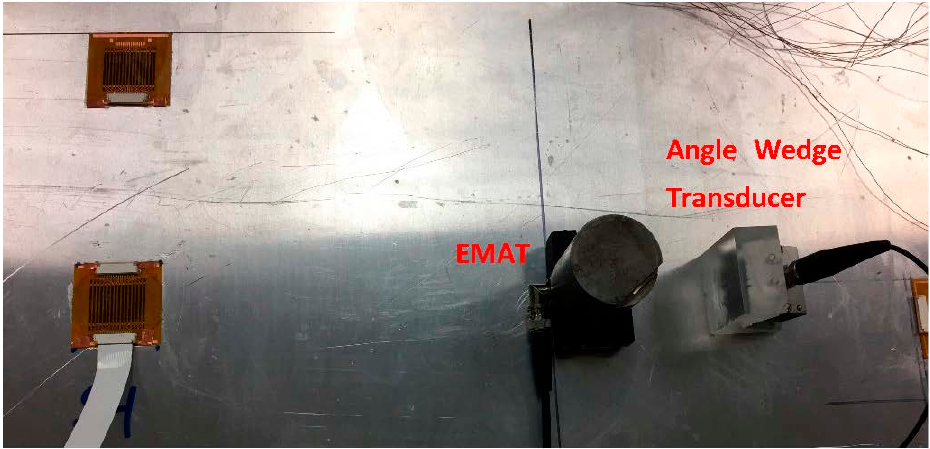
Figure 12. Experimental setup for modal decomposition. An angle wedge transducer and EMAT are used to generate mixed wave simultaneously.